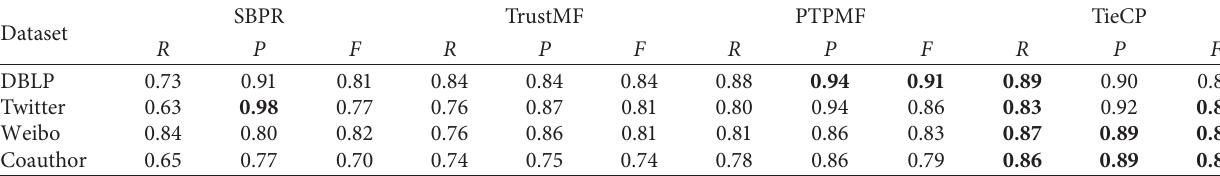
Table 2: The performance comparisons of different